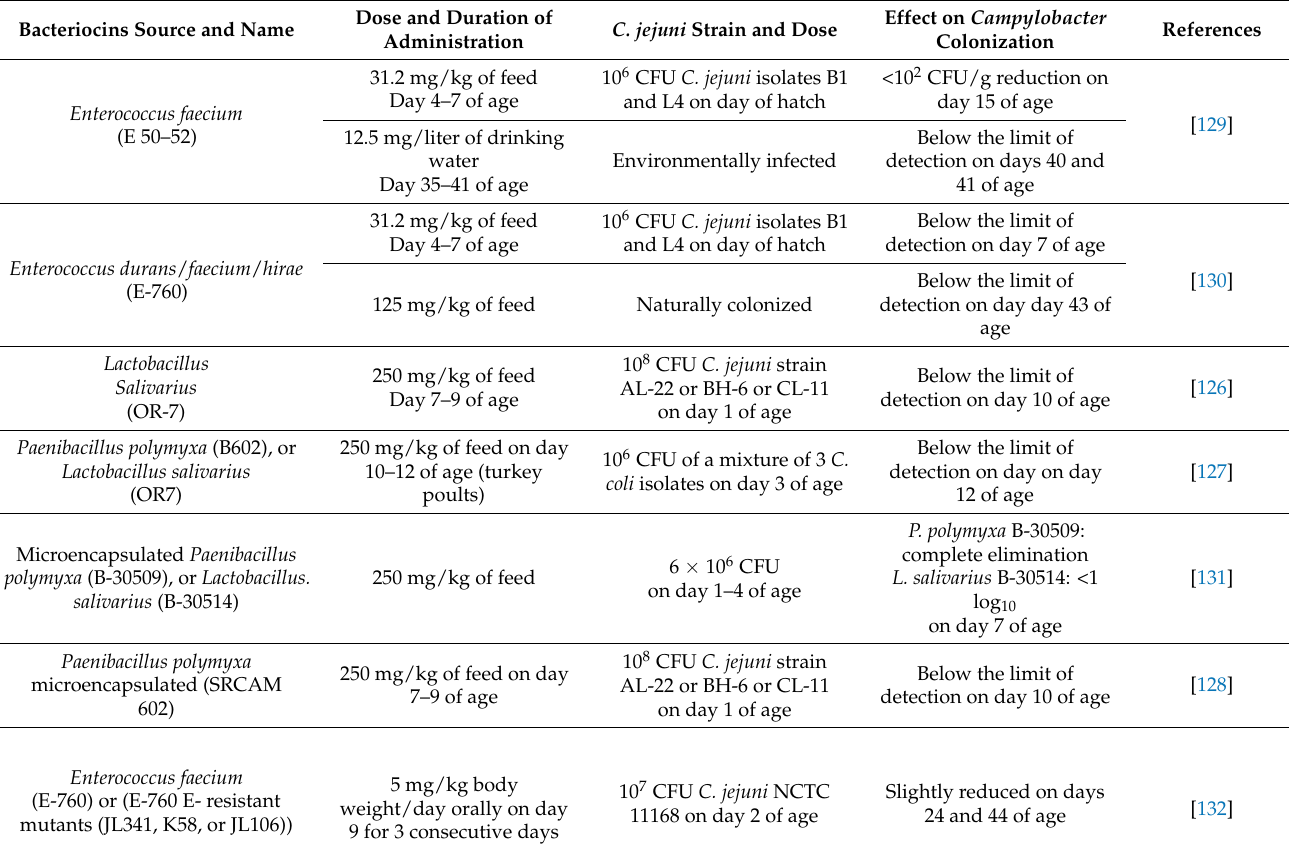
Table 3. Bacteriocins used for the treatment of Campylobacter colonization in poultry (modified from